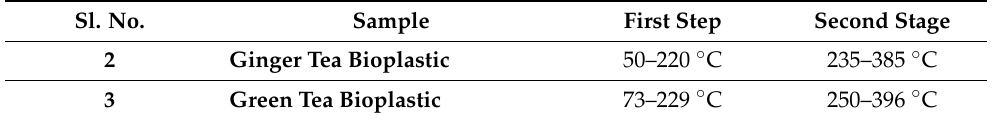
Table 4. TGA test results of bioplastics samples.